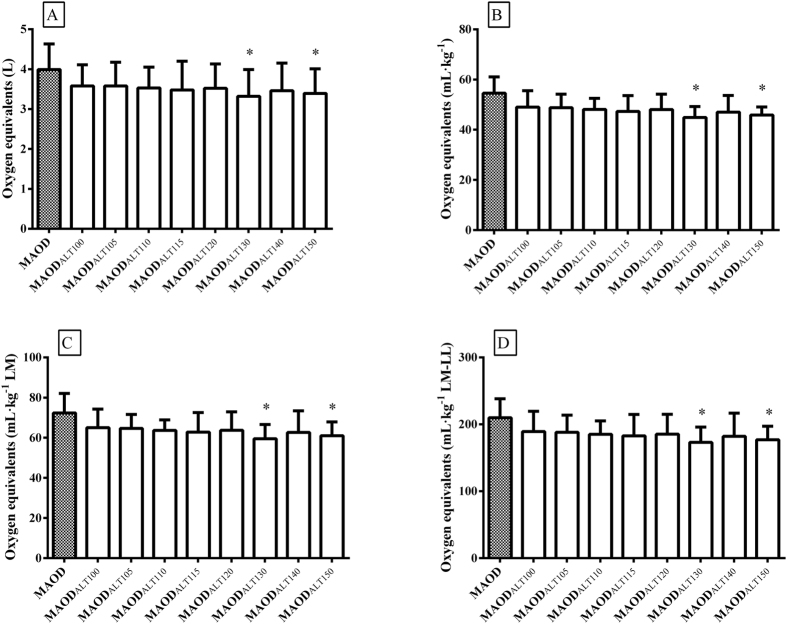
Comparison of the maximal accumulated oxygen deficit determined by the conventional method (MAOD) and alternative method (MAODALT).The MAODALT was determined at intensities of 100, 105, 110, 115, 120, 130, 140, and 150% of the intensity associated with maximal oxygen uptake (MAODALT100, MAODALT105, MAODALT110, MAODALT115, MAODALT120, MAODALT130, MAODALT140, and MAODALT150). The MAOD and MAODALT values are presented in absolute (A), relative to body mass (B), lean mass (LM) (C), and lean mass of lower limb values (LM-LL) (D). *p < 0.05 to MAOD.